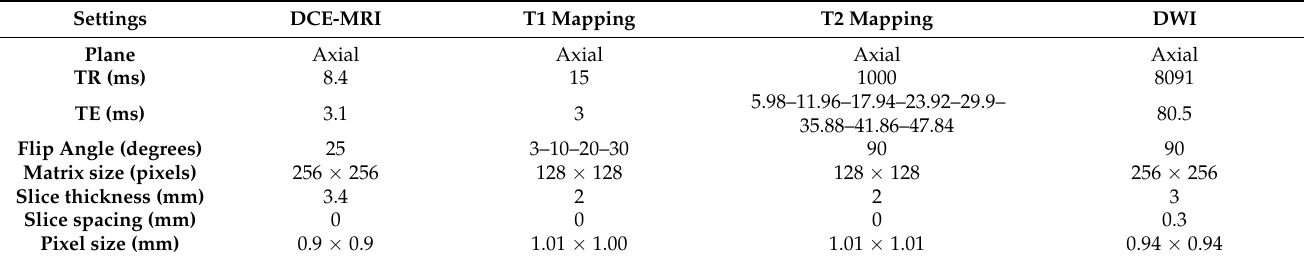
Table 2. Acquistion parameters for MRI.